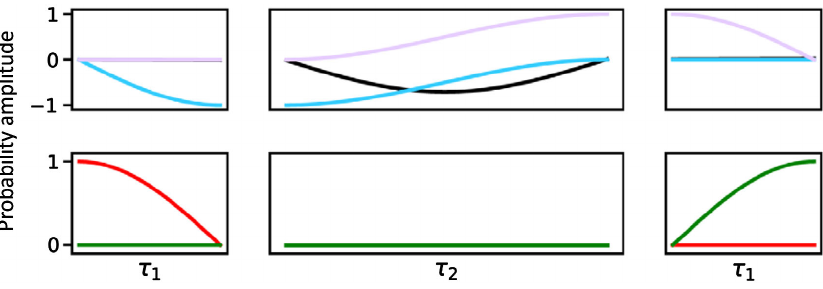
FIG. 5. Time evolution of the mechanical and spin systems with G=g ¼ 100 during the three successive swaps of the state transfer between two single spins, with the same peak value G for both G 1 and G 2 . Top: resonator mode 1 (blue), resonator mode 2 (purple), and waveguide mode (black). Bottom: spin 1 (red) and spin 2